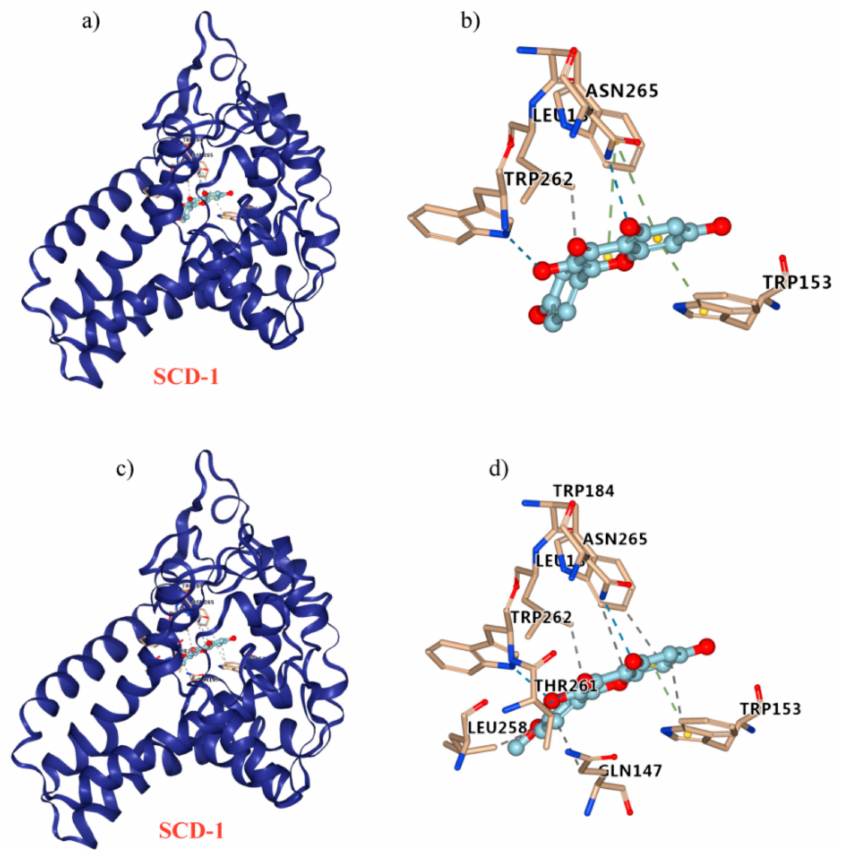
Figure 9. Molecular docking to predict the binding of kaempferol and kaempferide to SCD-1. ( a ) General overview of kaempferol docking into SCD-1. ( b ) Demonstration of the predicted binding conformation and corresponding interaction amino acid residues in ( a ). ( c ) General overview of kaempferide docking into SCD-1. ( d ) Demonstration of the predicted binding conformation and corresponding interaction amino acid residues in ( c